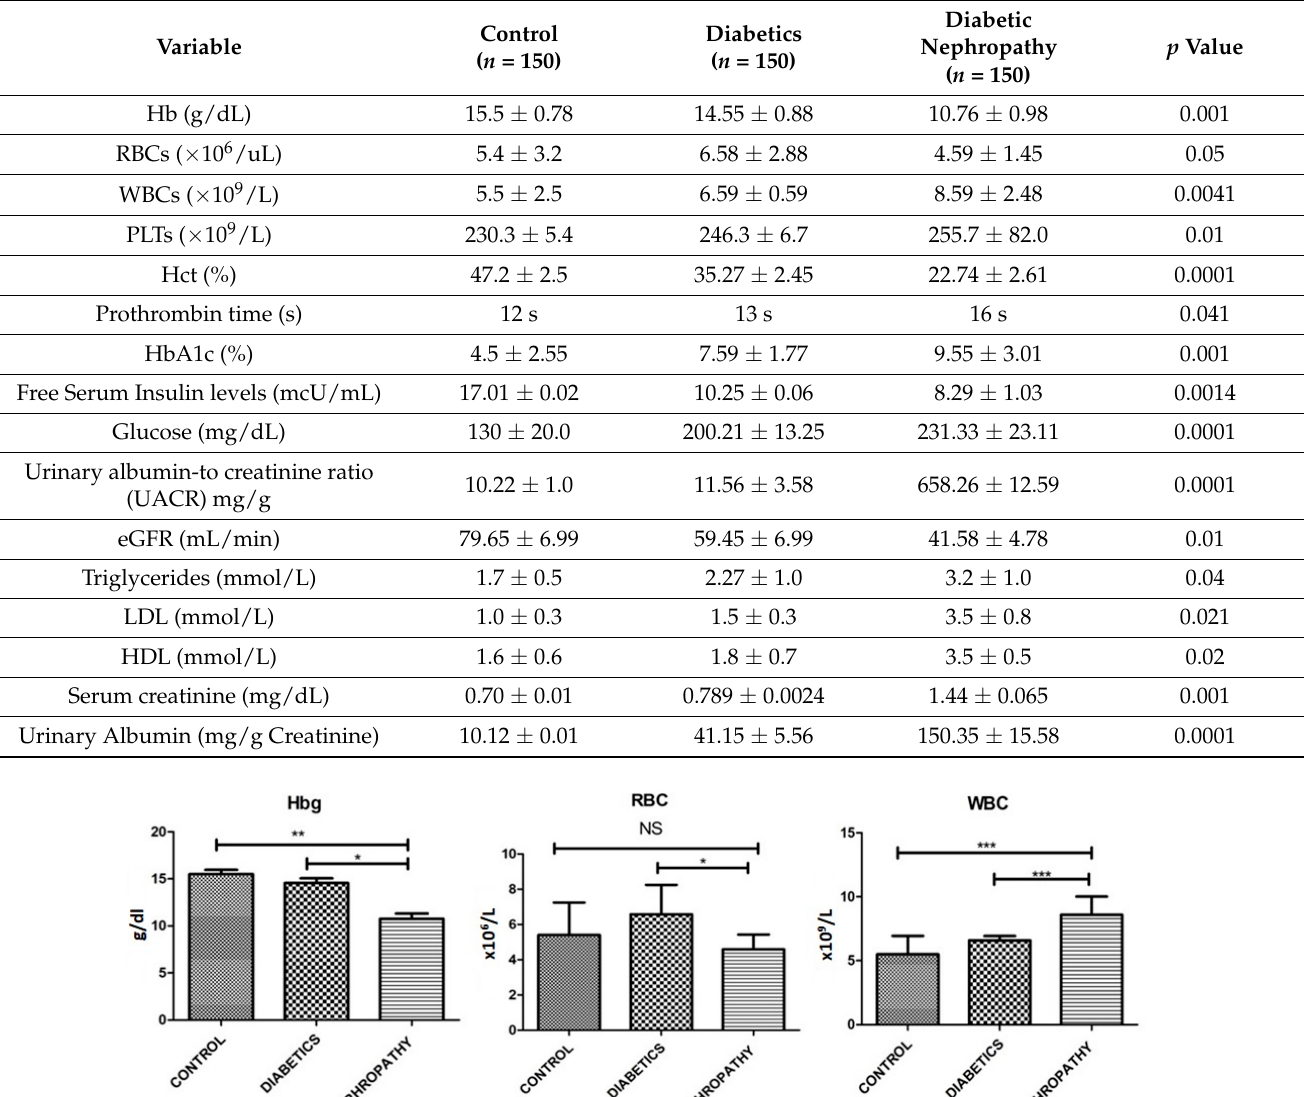
Table 2. Biochemical profile of diabetics. Diabetic nephropathy subjects vs. healthy age matched control.